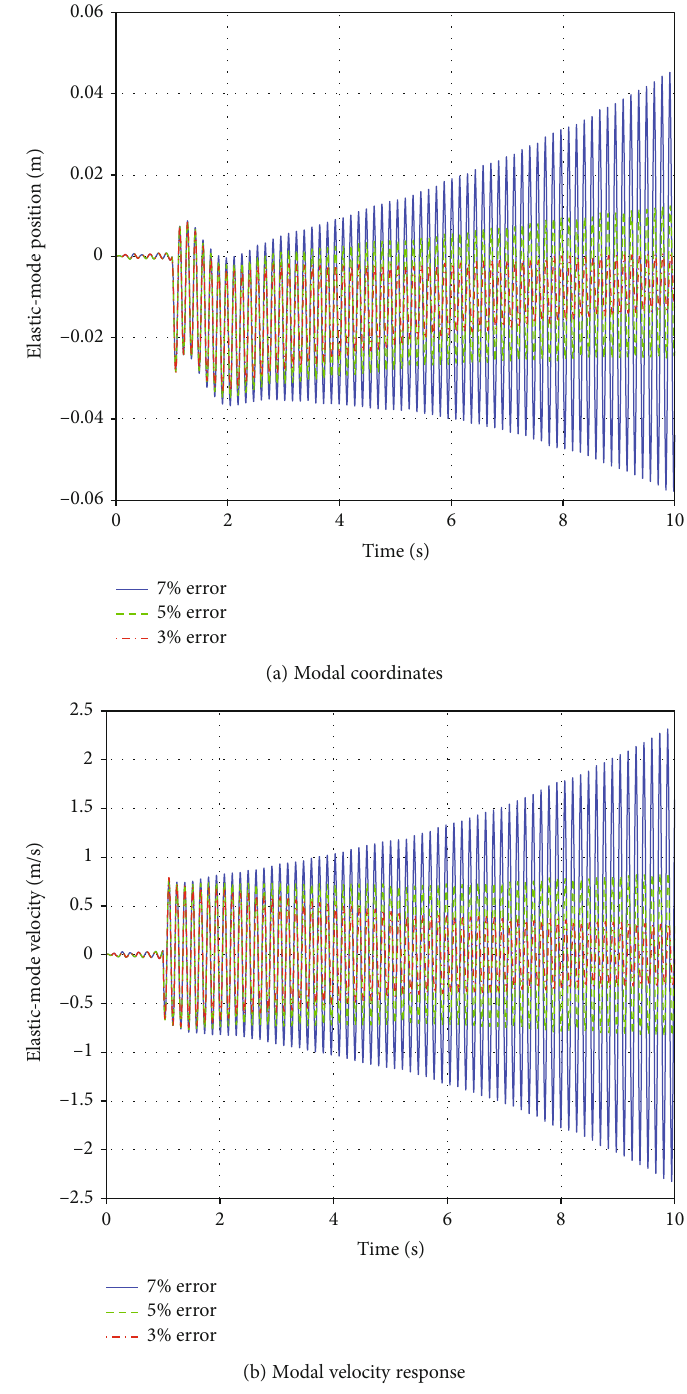
Figure 19: Modal coordinates and modal velocity